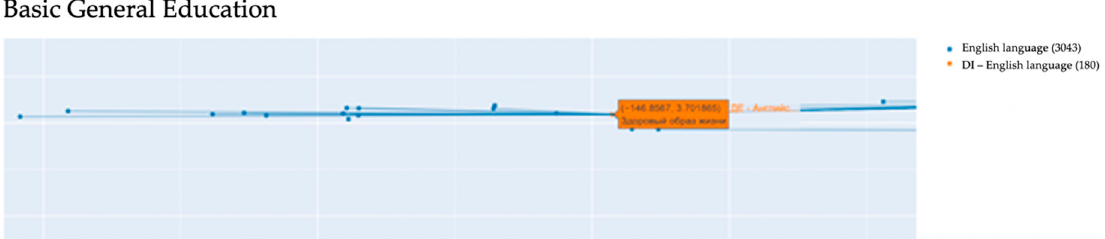
Figure 7. Semantic cluster “Healthy Lifestyle”.